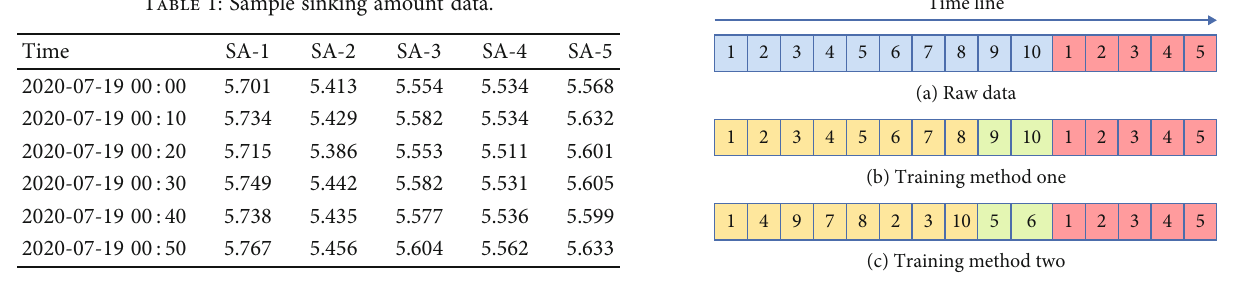
Table 2: Sample soil pressure of foot blades data. Figure 4: Training